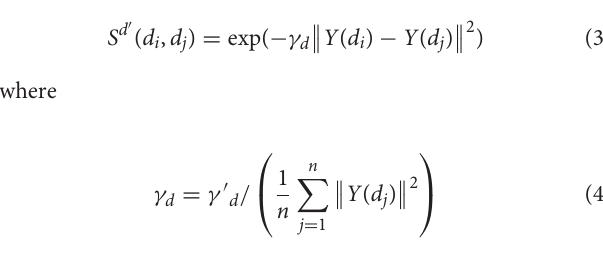
( Y 1 j , Y 2 j , . . . , Y mj )) denotes the interaction profile of disease d